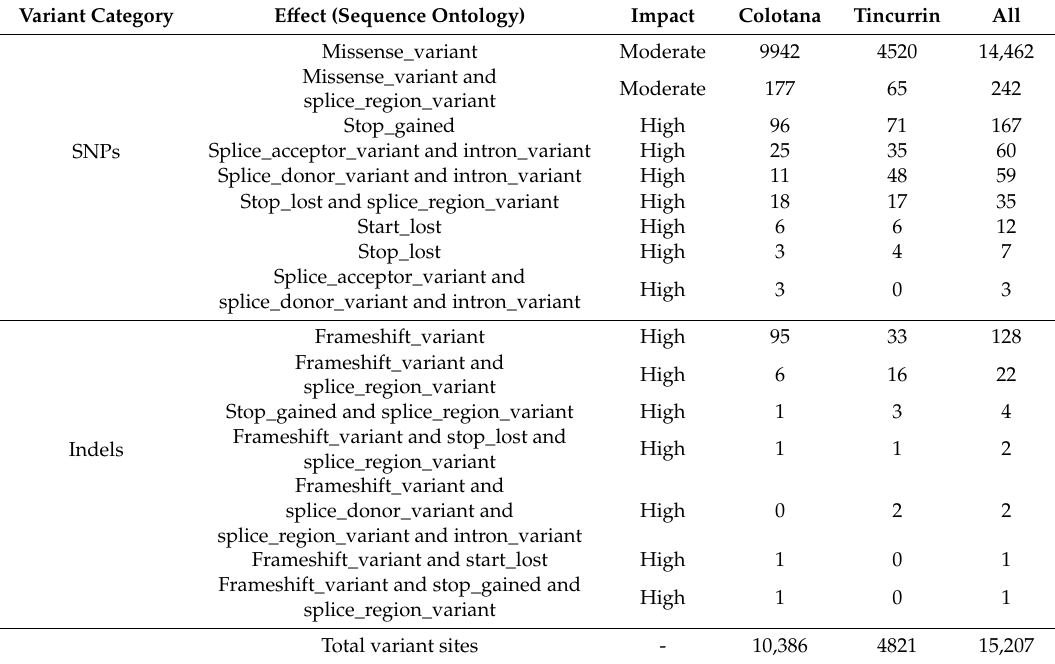
Table 1. Summary of variant calling between Colotana and